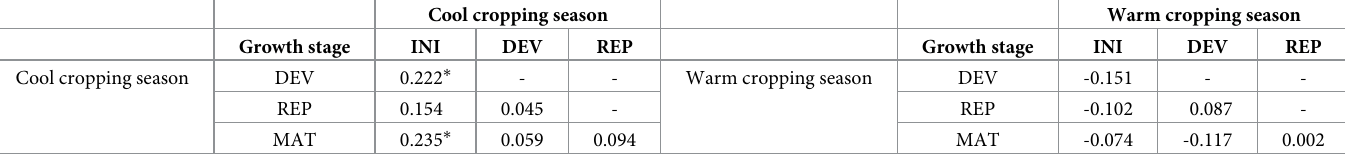
Table 2. Correlation coefficients of crop water status among growth stages in the cool and warm cropping